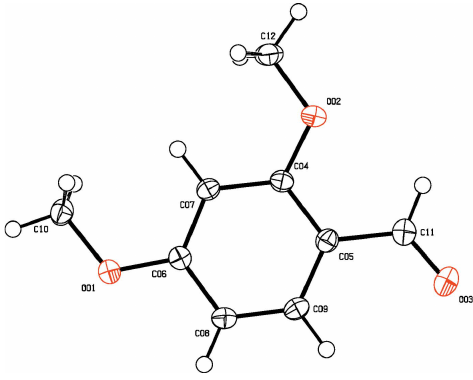
Figure 2 The molecular structure of 2,4-DMBz, showing displacement ellipsoids drawn at the 50% probability level.